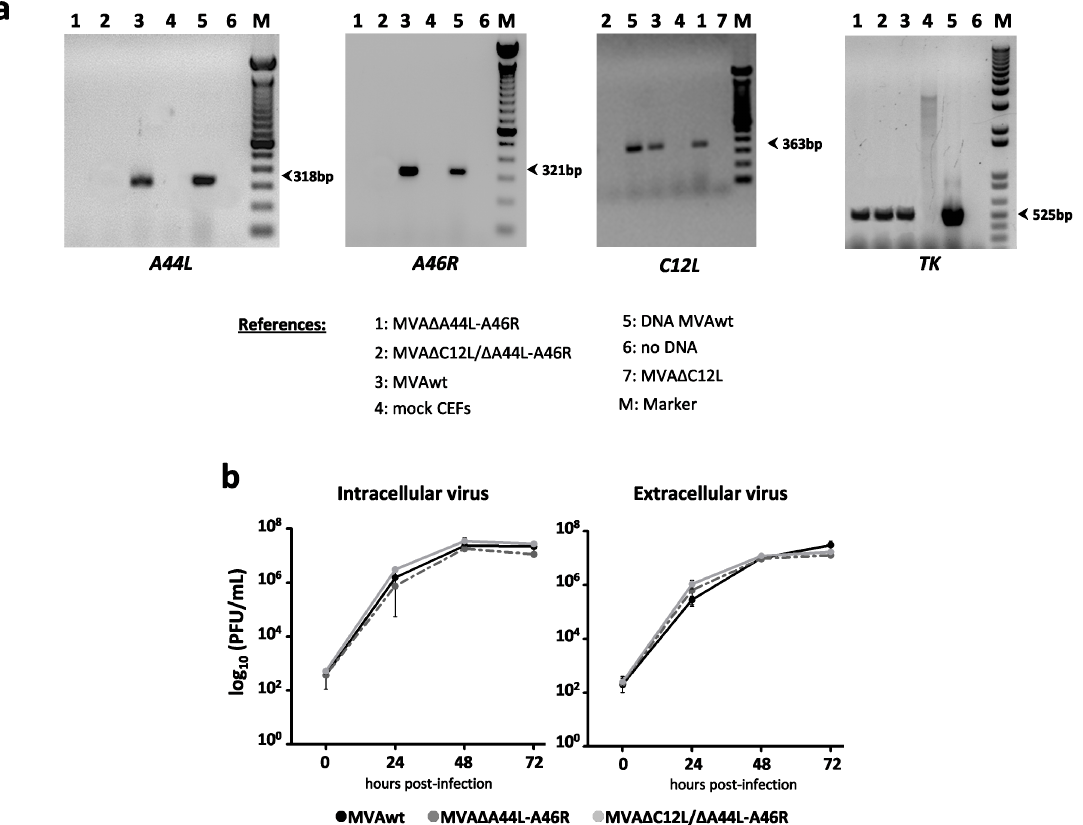
Figure 1. In vitro characterization of MVA ∆ A44L-A46R and MVA ∆ C12L/ ∆ A44L-A46R. ( a ) RNA was extracted from mock or infected CEFs with the different MVAs at 24 hpi (moi = 1), specific mRNAs were assessed by RT-PCR; and ( b ) virus growth kinetics of MVA vectors. BHK-21 were infected with the indicated MVA at moi = 0.01. At different hpi virus production was titrated by immunostaining.